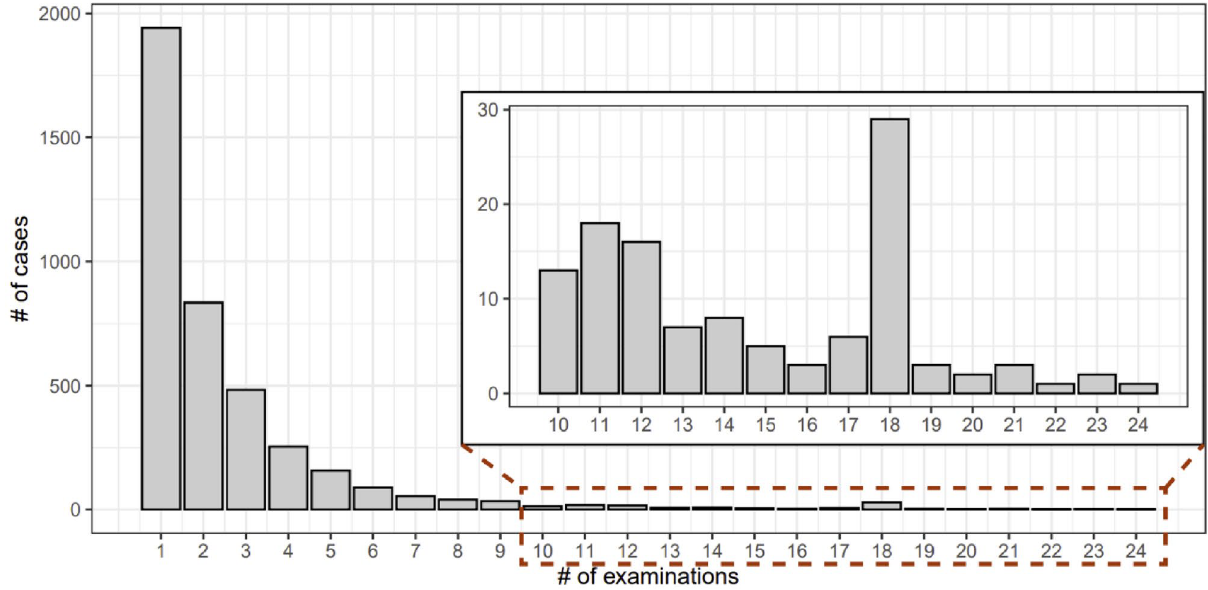
Figure 1. The number of cases according to the number of examinations performed to determine serum creatinine